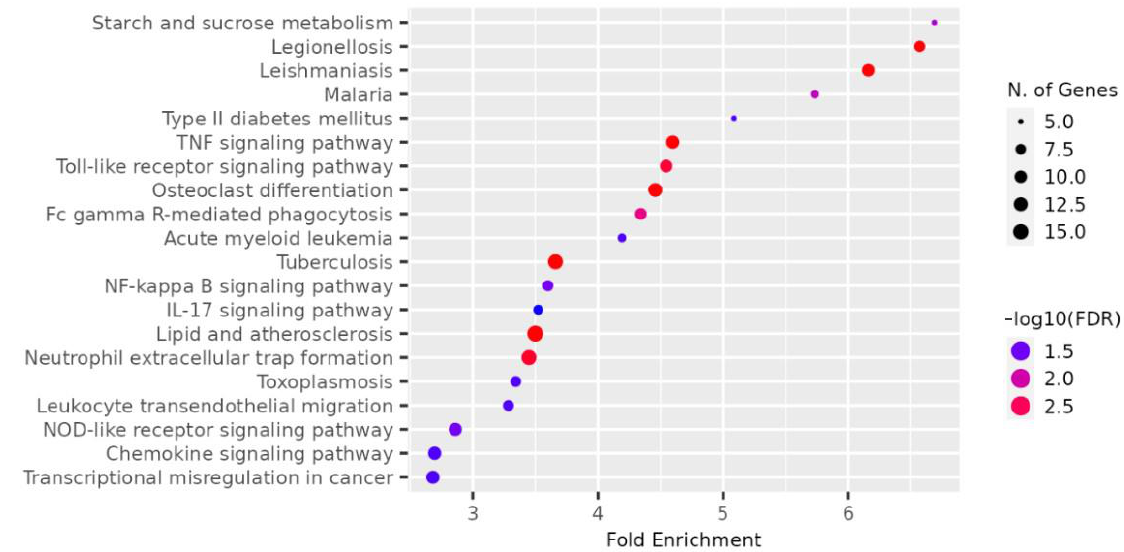
Figure 12. Gene network for top 20 enriched pathways for genes module, MEcyan based on GO biological process annotation.